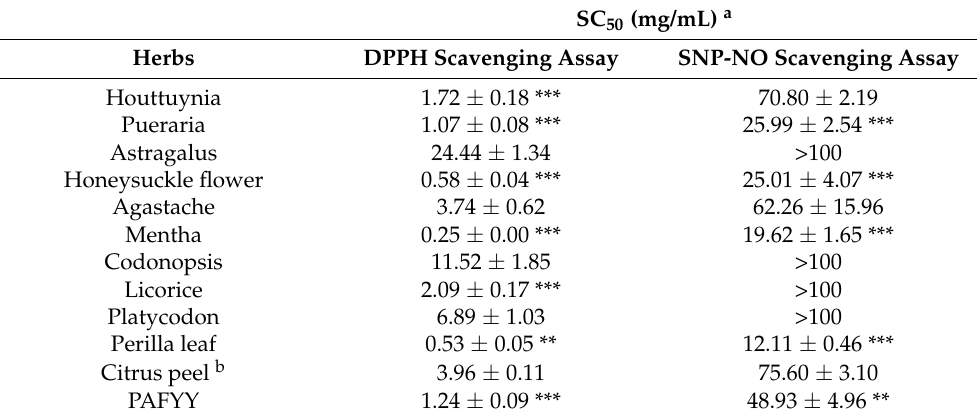
Figure 3. Antioxidant activity as measured by DPPH ( A ) and SNP-NO ( B ) assays as described for PAFYY. Asterisks show significant differences compared to control based on one-way ANOVA with Dunnett’s multiple comparison test (** p < 0.01 and *** p < 0.001). Table 2. Antioxidative activity of aqueous extract solutions of PAFYY and individual herbs measured by DPPH and SNP-NO scavenging